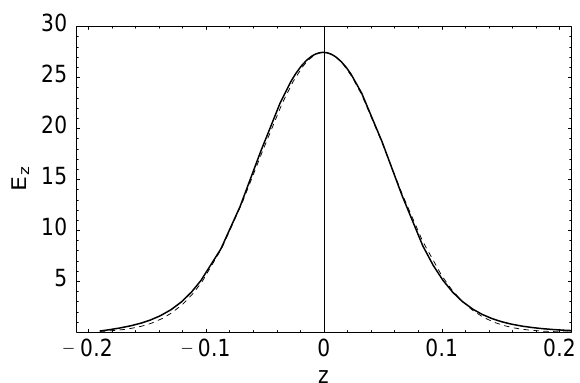
FIG. 3. Longitudinal component of the on axis electric field (arbitrary units) for the fundamental mode in a 1-cell APT b (cid:173) (cid:48)(cid:46)(cid:54)(cid:52) cavity with a power coupler versus (cid:122) (m): MAFIA results (solid line) and analytical fit (dashed line).